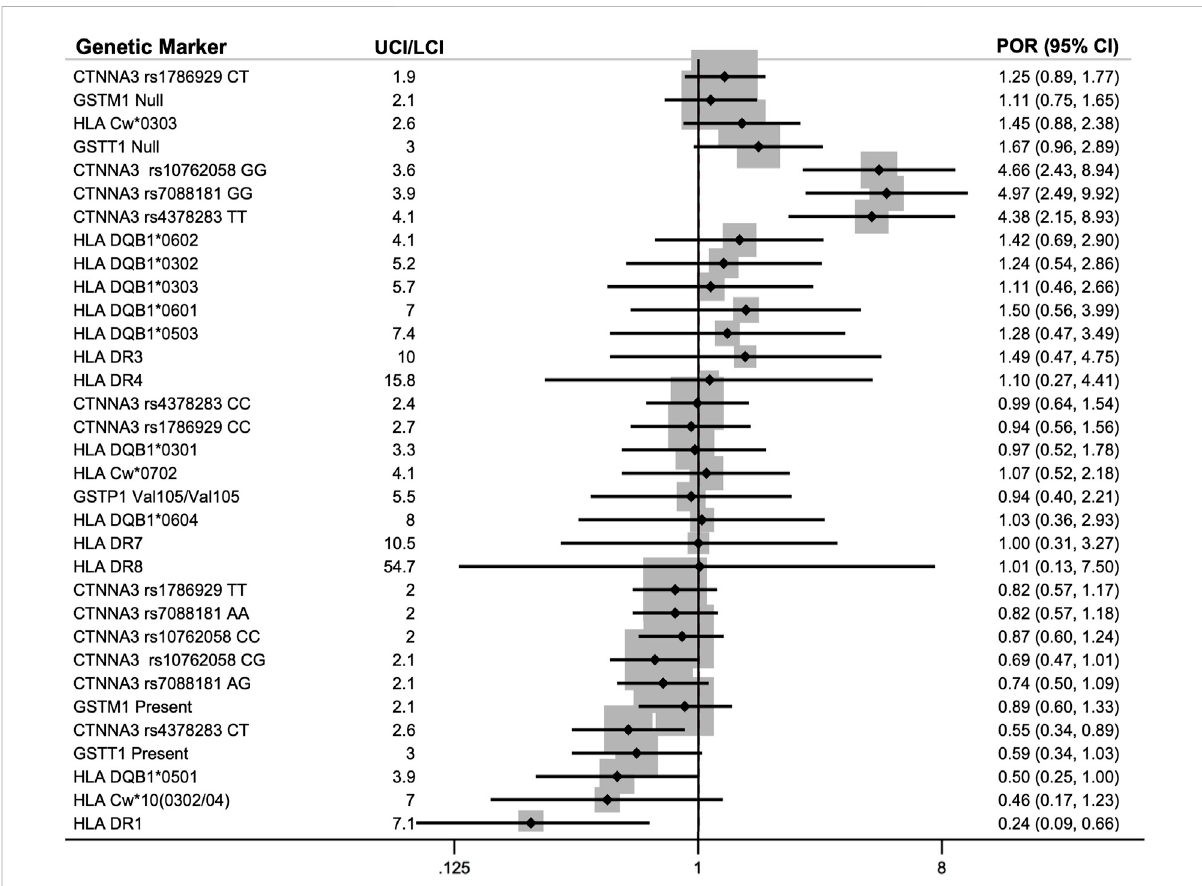
FIGURE 3 Pooled prevalence odds ratios (POR) for association of genetic markers with diisocyanate asthma (DA) using an inverse-variance model (IV). Each of the 23 genetic markers was reported by two to three studies. The lower 95% con fi dence interval (LCI) and upper 95% con fi dence interval (UCI)areprovidedinparenthesisnexttothePOR.Themeta-analysesincludeddataforasymptomaticworker(AW)controlswhenavailableornormal controls (NC) when AWs were not studied. Markers with POR > 1.0 indicates a higher prevalence of that genotype within workers with DA (DA risk marker) and markers with POR < 1.0 had a lower prevalence within DA workers compared to the control group (protective marker against